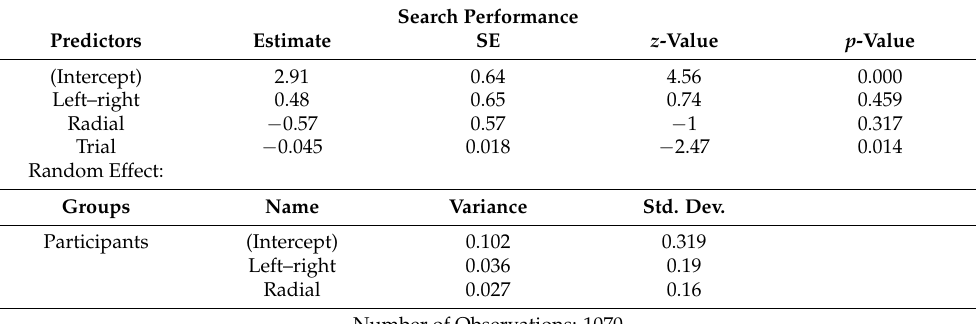
Table A5. Results of the analysis of search performance. The applied model was a binomial general- ized linear mixed-effects